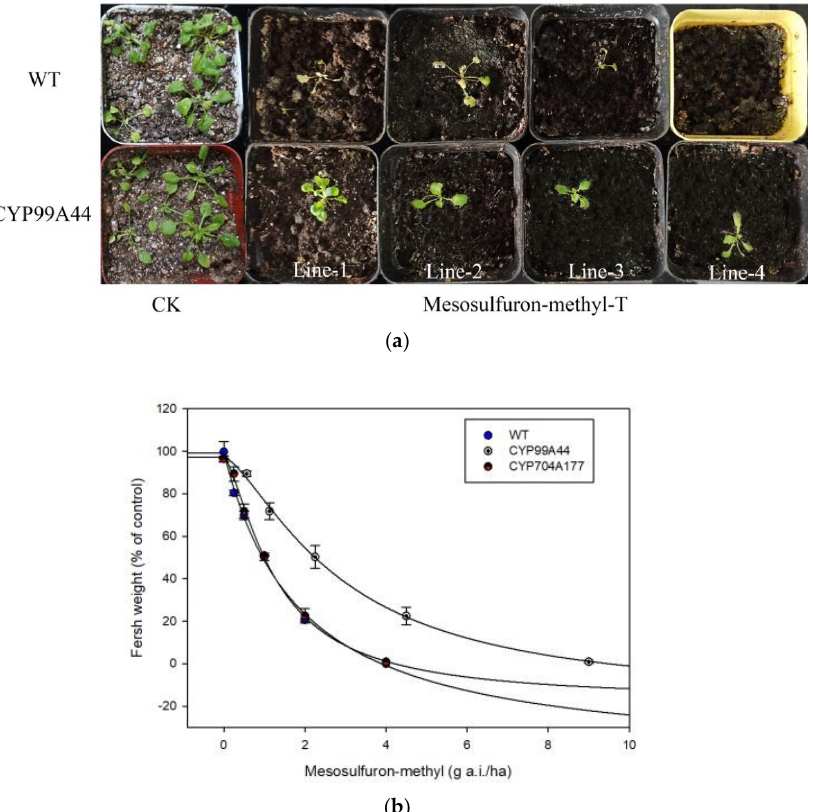
Figure 5. ( a ) Growth response of Arabidopsis (WT) and those transformed with CYP99A44 to mesosulfuron-methyl (Lines 1 – 4). Growth status was checked at 14 d after treatment at the rate of 0 (CK) or 3.38 g a.i./ha (Mesosulfuron-methyl-T). ( b ) Dose–response curves of independent transgenic lines to mesosulfuron-methyl. Bars represent SE ( n = 3).